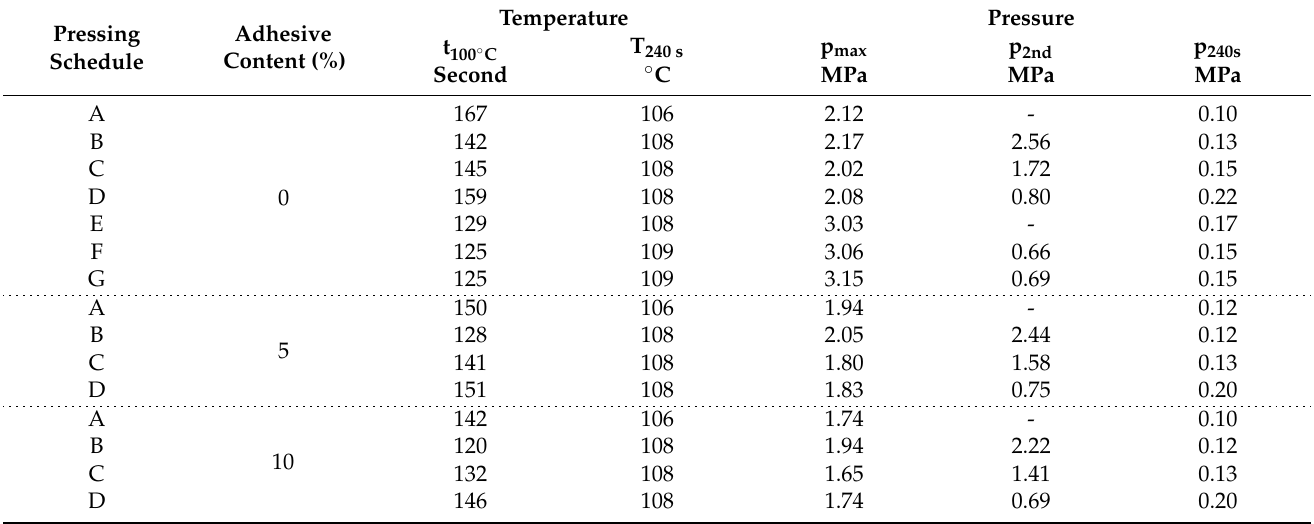
Figure 2. Temperature development for different pressing schedules, measured in fiber mats without adhesive. Table 2. Characteristic values of temperature and specific pressure curves for various pressing schedules.